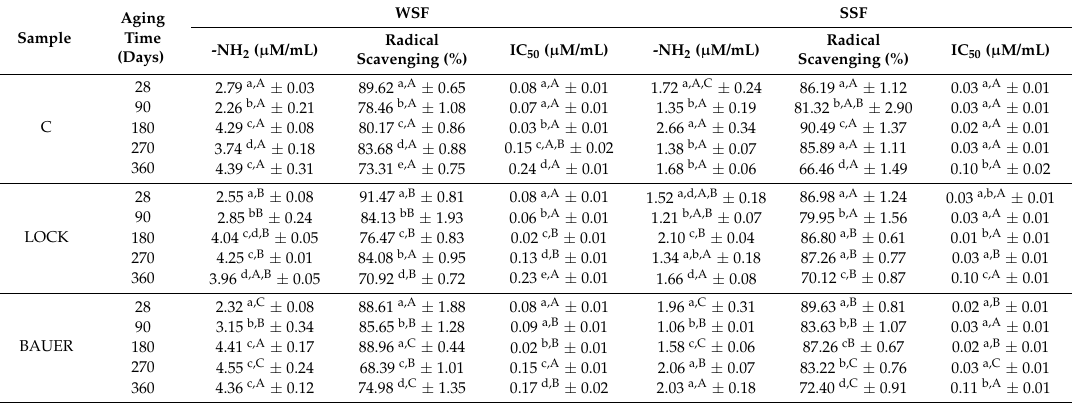
Table 6. Antiradical activity of protein hydrolysates after simulated adsorption (mean ± standard deviation).